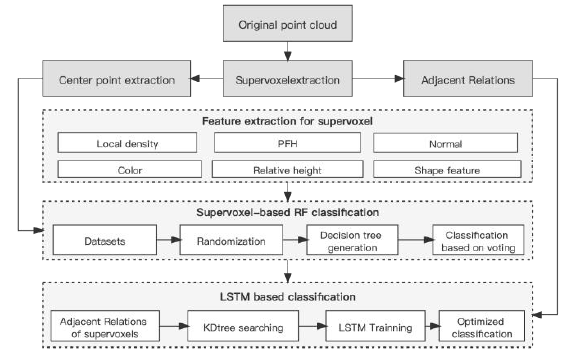
Figure 1 The framework of the proposed